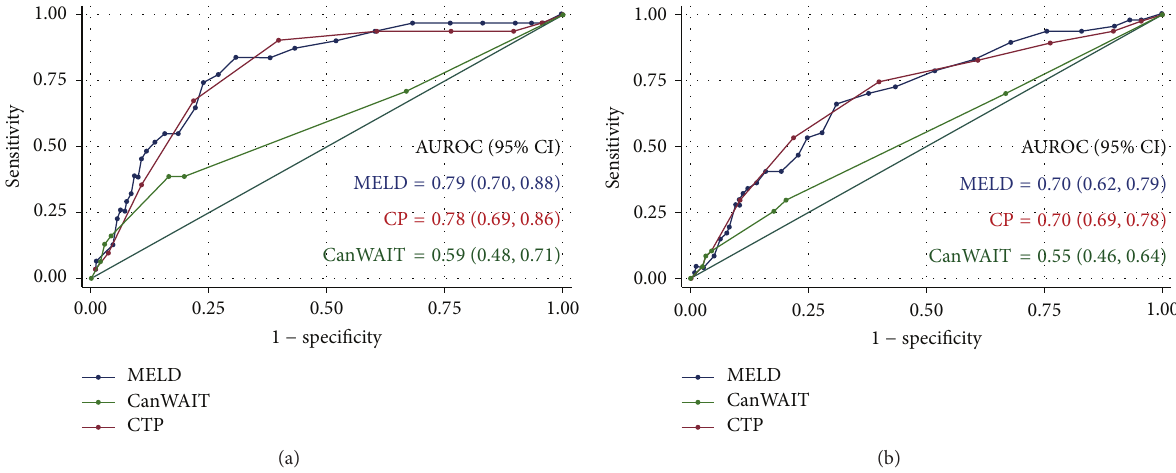
Figure 3: Receiver operating characteristic (ROC) curves for MELD, CP, and CanWAIT scores for prediction of 3-month (a) and 1-year (b) waiting list mortality.